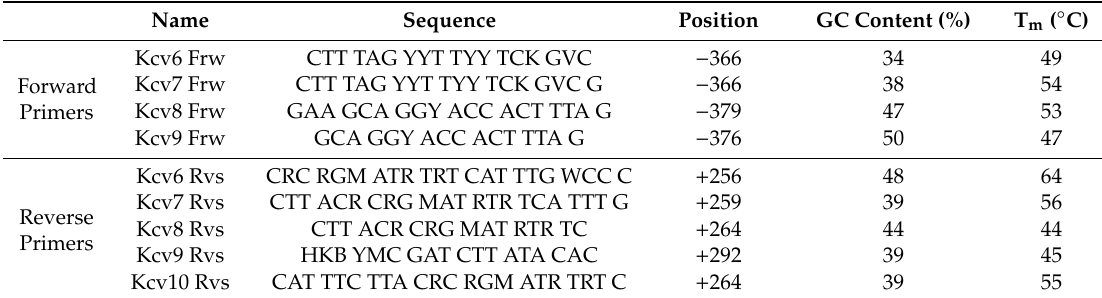
Table 1. Primers tested to isolate the kcv